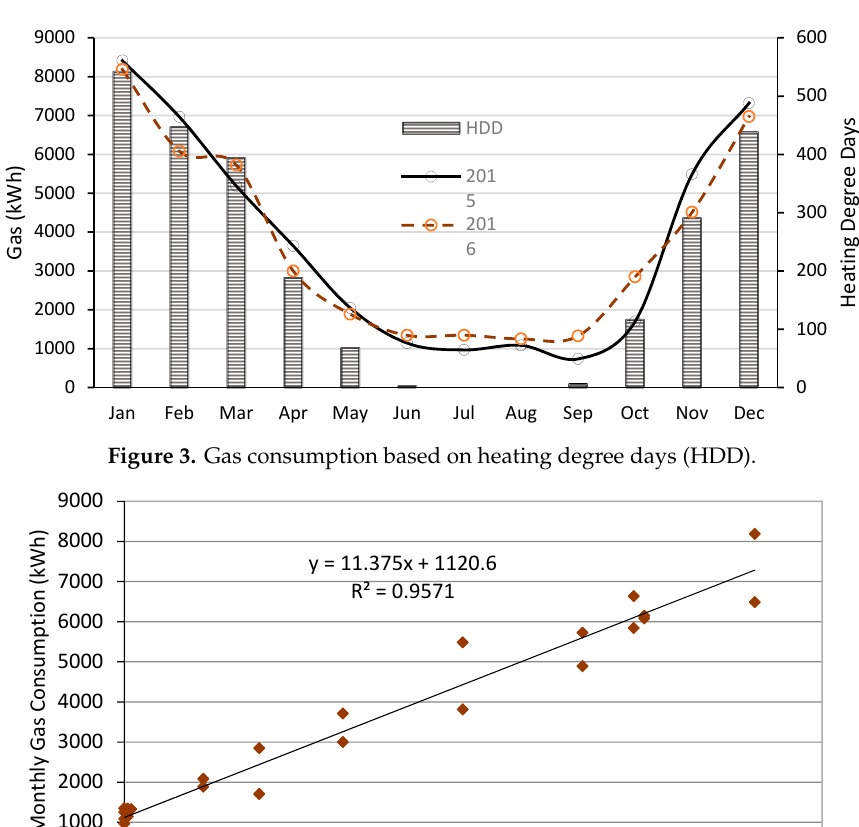
Figure 4. Linear regression between the natural gas consumption and the heating degree days (HDD).